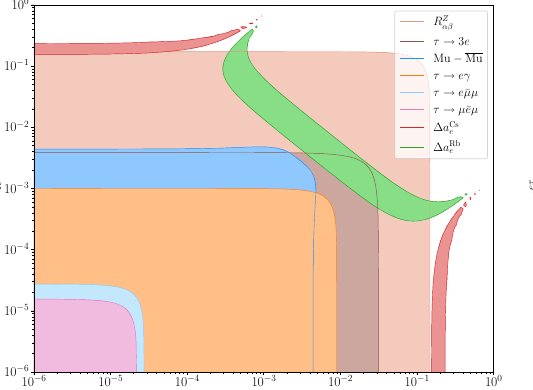
the red and the green regions respectively denote the 1 σ ( g − 2 ) Cs e and ( g − 2 ) Rb e favoured regimes. On the right, allowed regions in the ( g e τ - g e τ ) parameter space, in agreement with R μ e (τ → (cid:4)ν ¯ ν) (purple), L R μ → 3 e (brown), μ → e γ (orange) and μ − e conversion in Gold (turquoise); the red and the green regions respectively correspond to the 1 σ ( g − 2 ) Cs e and ( g − 2 ) Rb e favoured